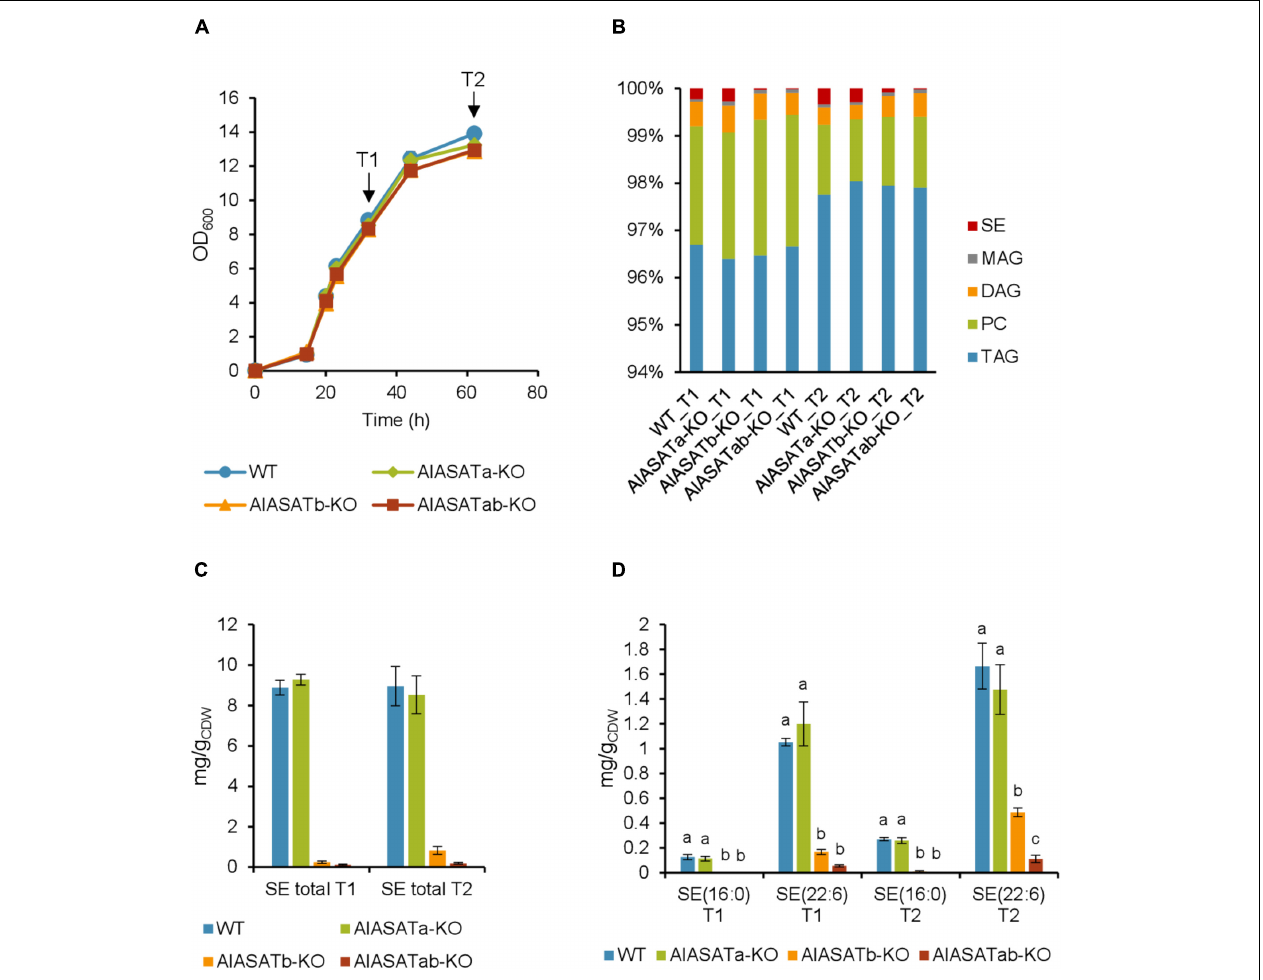
FIGURE 4 | Characterization of the SR21 KO strains AlASATa-KO, AlASATb-KO and AlASATab-KO compared to WT. (A) Growth measured as optical density (OD 600 ), sample collection points are indicated by arrows. (B) Distribution of different lipid classes. TAG, triacylglycerol; DAG, diacylglycerol; PC, phosphatidylcholine; MAG, monoacylglycerol; SE, steryl ester. The production (mg/g CDW ) of total SE (C) and SE species (D) from the strains. All data are expressed as the mean of the triplicates originating from three independent cultures; Error bars represent the standard deviation. The bars are separated into groups, each with a particular SE and time points. For each group, the bars with different lowercase letters on the top are statistically significantly different from each other ( P < 0.05), based on one-way analysis of variance (ANOVA), followed by post hoc Tukey